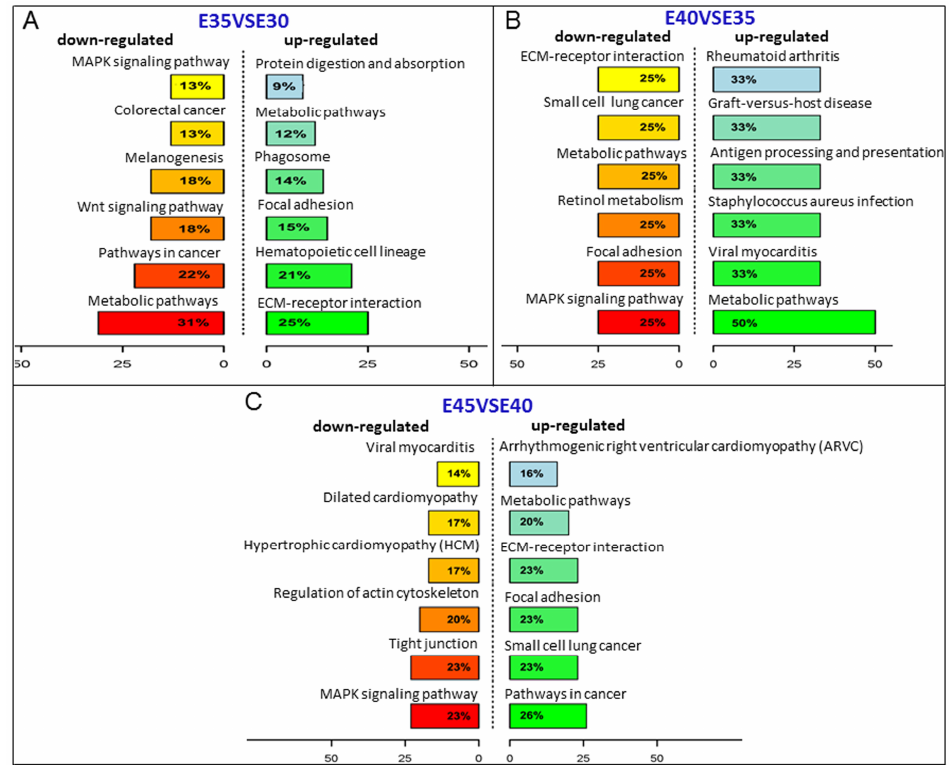
Figure 4. The significantly up- and down-regulated pathways during secondary palatal development. ( A ) The significant up- and down-regulated pathways between E35VSE30; ( B ) The significant up- and down-regulated pathways between E40VSE35; ( C ) The significant up- and down-regulated pathways between E45VSE40. The y axis shows the pathways and the x axis shows the rich factor (DEGs in the pathway/total DEGs).